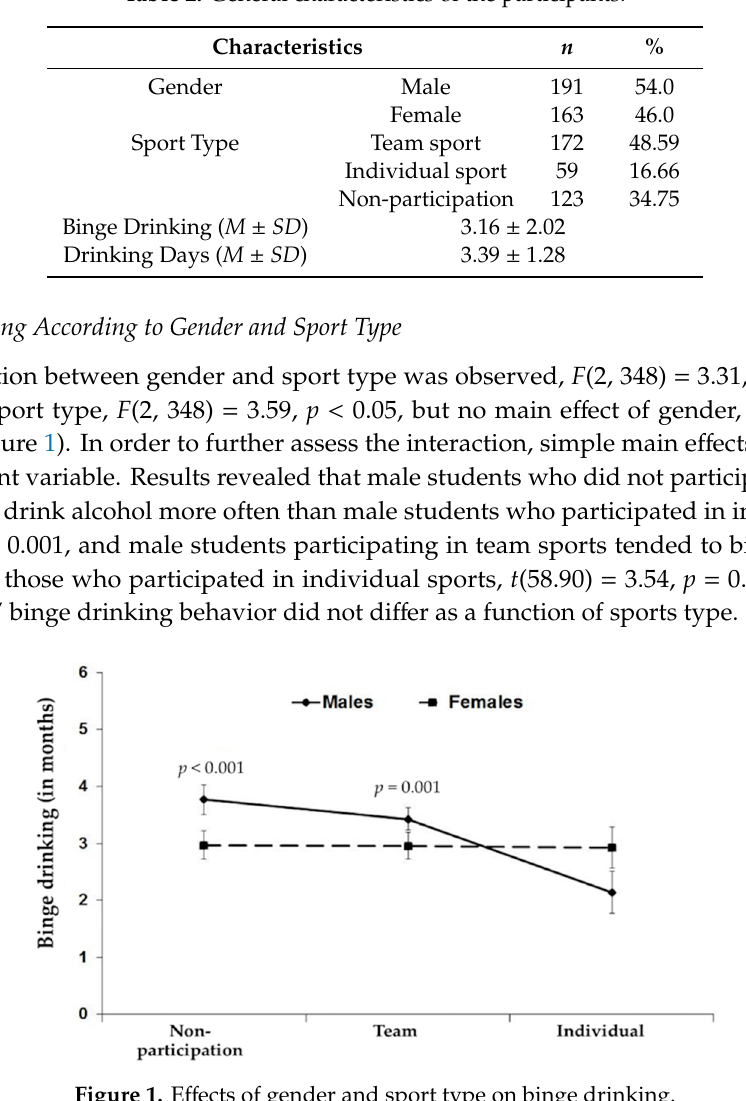
Figure 1. E ff ects of gender and sport type on binge Figure 1. Effects of gender and sport type on binge drinking.